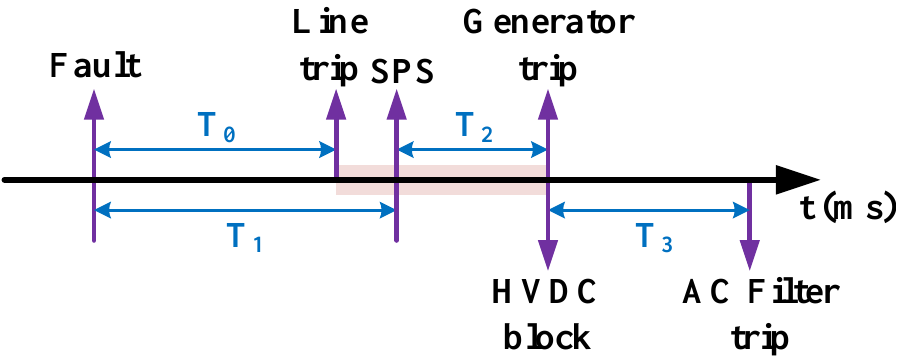
Figure 2. Double-line fault scenario between bus 1 and bus 2 shown in Figure 1 for analysis of tempo- rary transient overvoltage (TOV) with respect to MOV surge arrester with LCC-HVDC transmission system with special protection